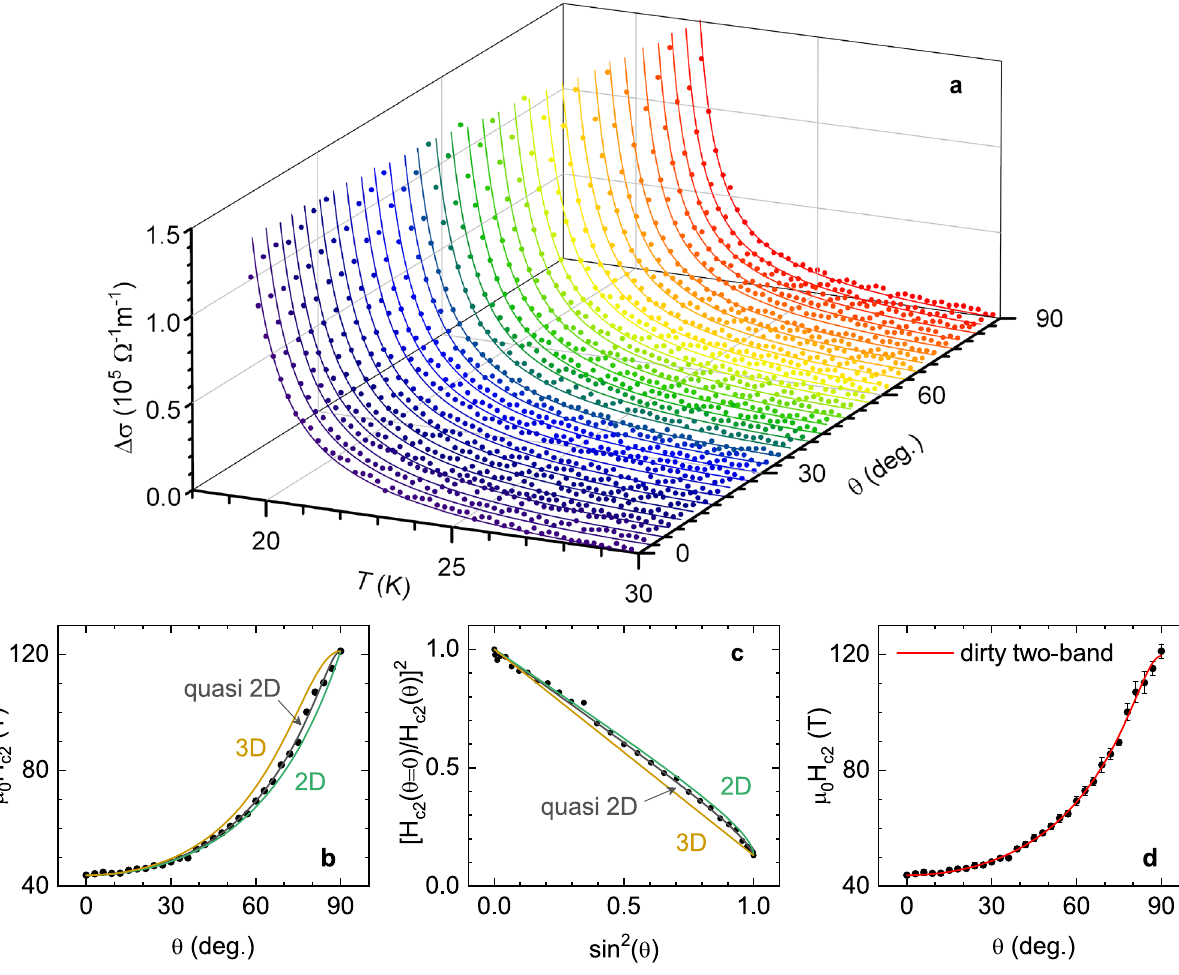
Figure 3. ( a ) Temperature dependence of the fluctuation conductivity obtained with a 9 T magnetic field, for different orientations relative to the crystal c axis ( θ -steps of 3 ◦ between 0 and 90 ◦ ). The lines are the best fits of Eq. (3), with the ξ c ( 0 ) value resulting from the analysis in Fig. 2 d , and H c 2 (θ) as the only free parameter. The resulting H c 2 (θ) are the data points in ( b , c and d ) (the error bars are only shown in d for clarity). ( b ) H c 2 (θ) data compared to the single-band 3D-anisotropic GL approach, (orange line, Eq. (1)), the 2D Tinkham’s result (green line, Eq. (5)) and quasi-2D Mineev’s result (black line, Eq. (6)). ( c ) Same plot as ( b ), in a linearized scale. ( d ) H c 2 (θ) compared with Gurevich’s approach for dirty 2-band superconductors (Eq.